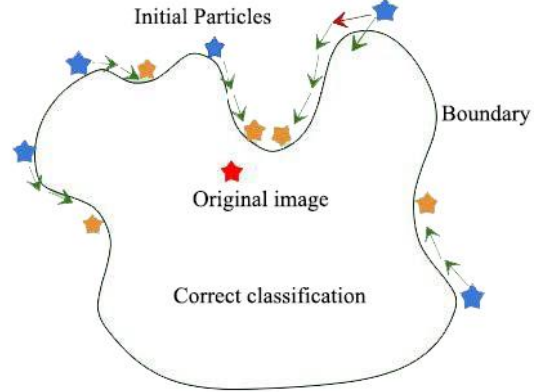
Figure 4. The process of particle swarm searching for optimal adversarial examples.